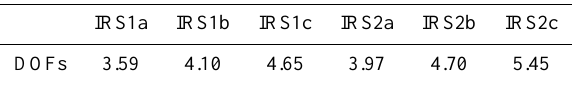
Table 9. Vertical information expressed in DOFs of the ozone re- trievals for each scenario.